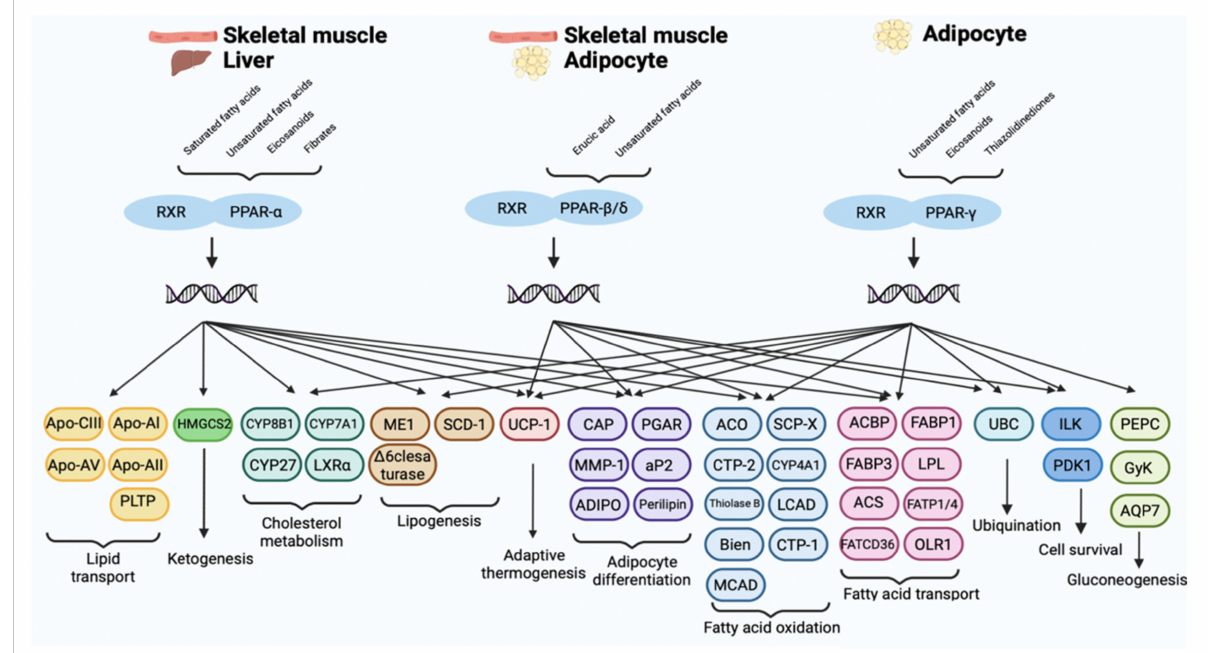
Figure 3. A schematic representation at cellular level of PPARs